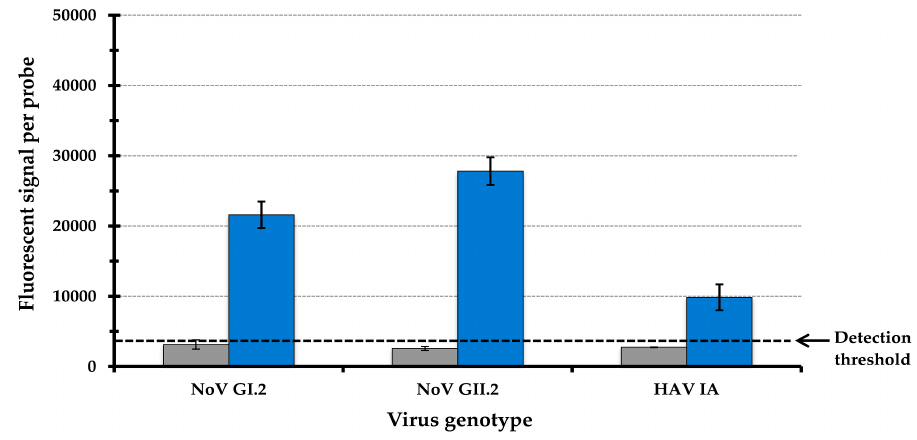
Figure 4. Hybridization signals of the tested NoV and HAV genotypes at 10 2 cRNA transcript copies in the absence (grey bars) or presence (blue bars) of a 12-mer oligonucleotide spacer sequence attached to the capture probe. The sensitivity detection threshold of the array-based typing method was set at 4000 fluorescent counts and is indicated by the dashed line.